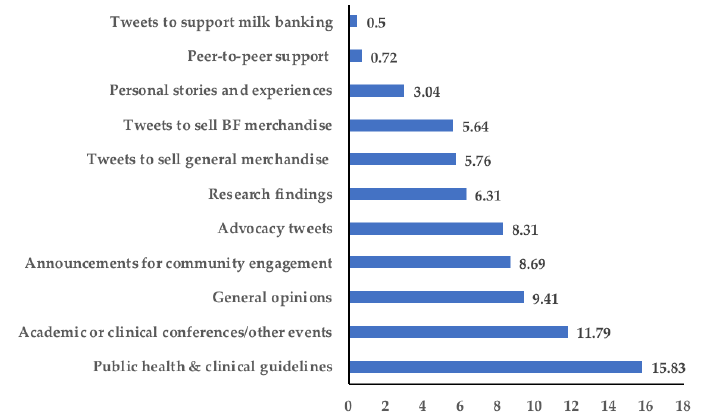
Figure 2. Distribution of influencers’ tweet content ( n = 1373 tweets).